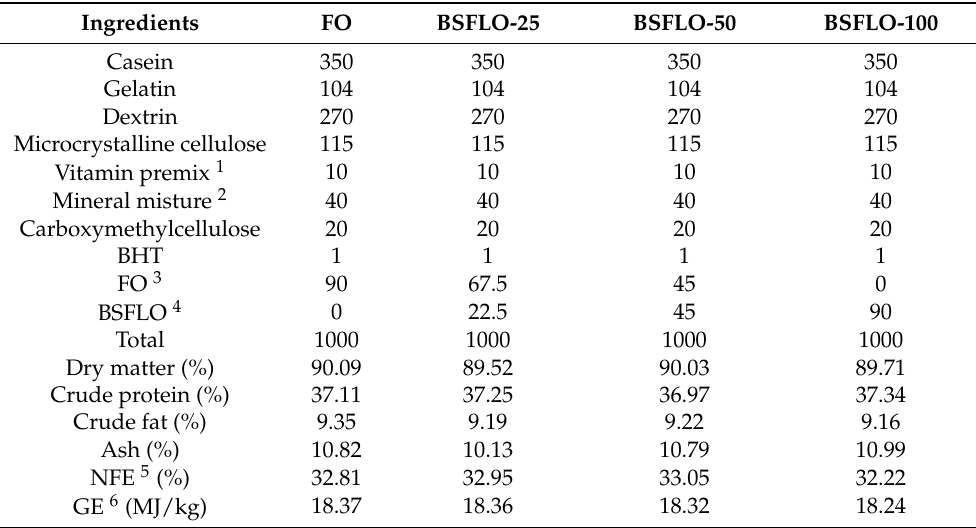
Table 1. Ingredients (g/kg) and proximate composition of the four experimental diets with different gradient levels of BSFLO (25%, 50% and 100%) replacing FO (control). Ingredients